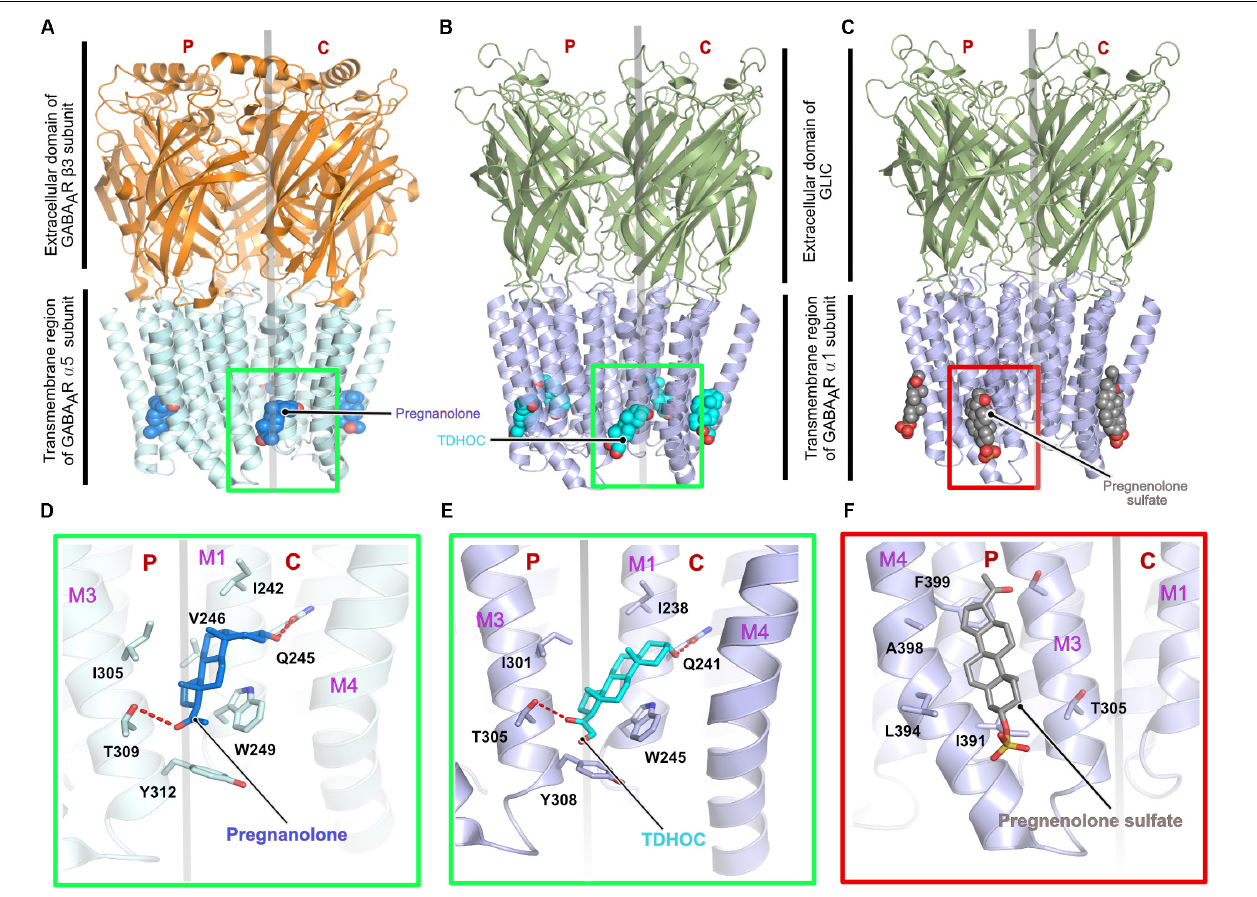
FIGURE 4 | Architecture of the chimeric GABA A Rs. (A) Crystal structure of a chimeric GABA A R, resulting from the fusion of the transmembrane domain of the α 5 subunit and the extracellular domain (ECD) of the β 3 subunit, in complex with pregnanolone (PDB: 5O8F). Crystal structure of a chimeric GABA A R, resulting from the fusion of the transmembrane domain of the α 1 subunit and the ECD of the prokaryotic GLIC, in complex with TDHOC ( B , PDB: 5OSB) and pregnenolone sulfate ( C , PDB: 5OSC). In all cases, the bound ligand is shown in space filling representation and the receptor as cartoon. Enlarged views of the ligand binding pocket of the potentiators, pregnanolone (D) and TDHOC (E) as well as the inhibitor pregnenolone sulfate (F) . Residues contributed by either the principal or complementary subunit are separated by a transparent gray line. The binding of the potentiators are mediated by the M3 helix from the principal and the M1 helix from the complementary subunit (D,E) , in contrast, binding of the inhibitory pregnenolone sulfate is mediated by helices M3 and M4 from the principal subunit (F)